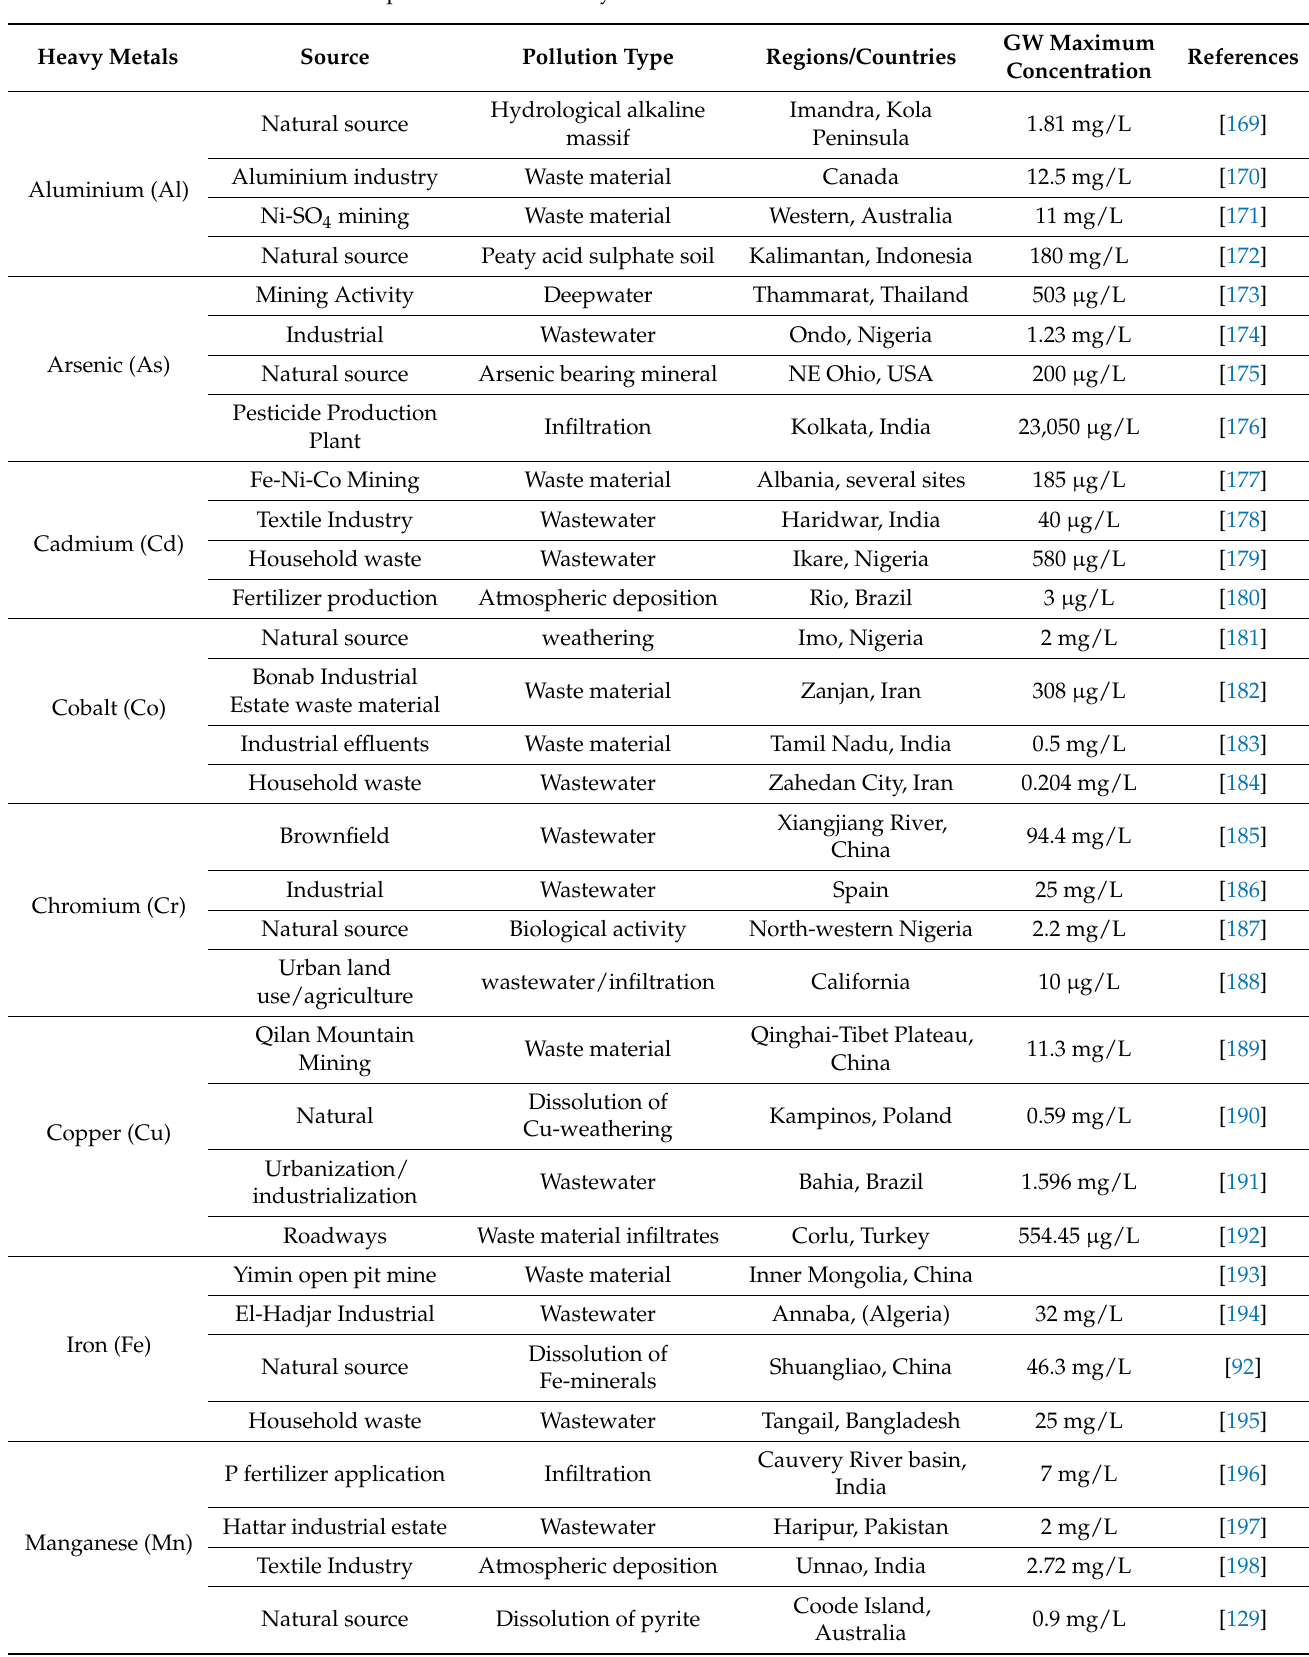
Table 3. Water pollution due to heavy metals in numerous countries across the